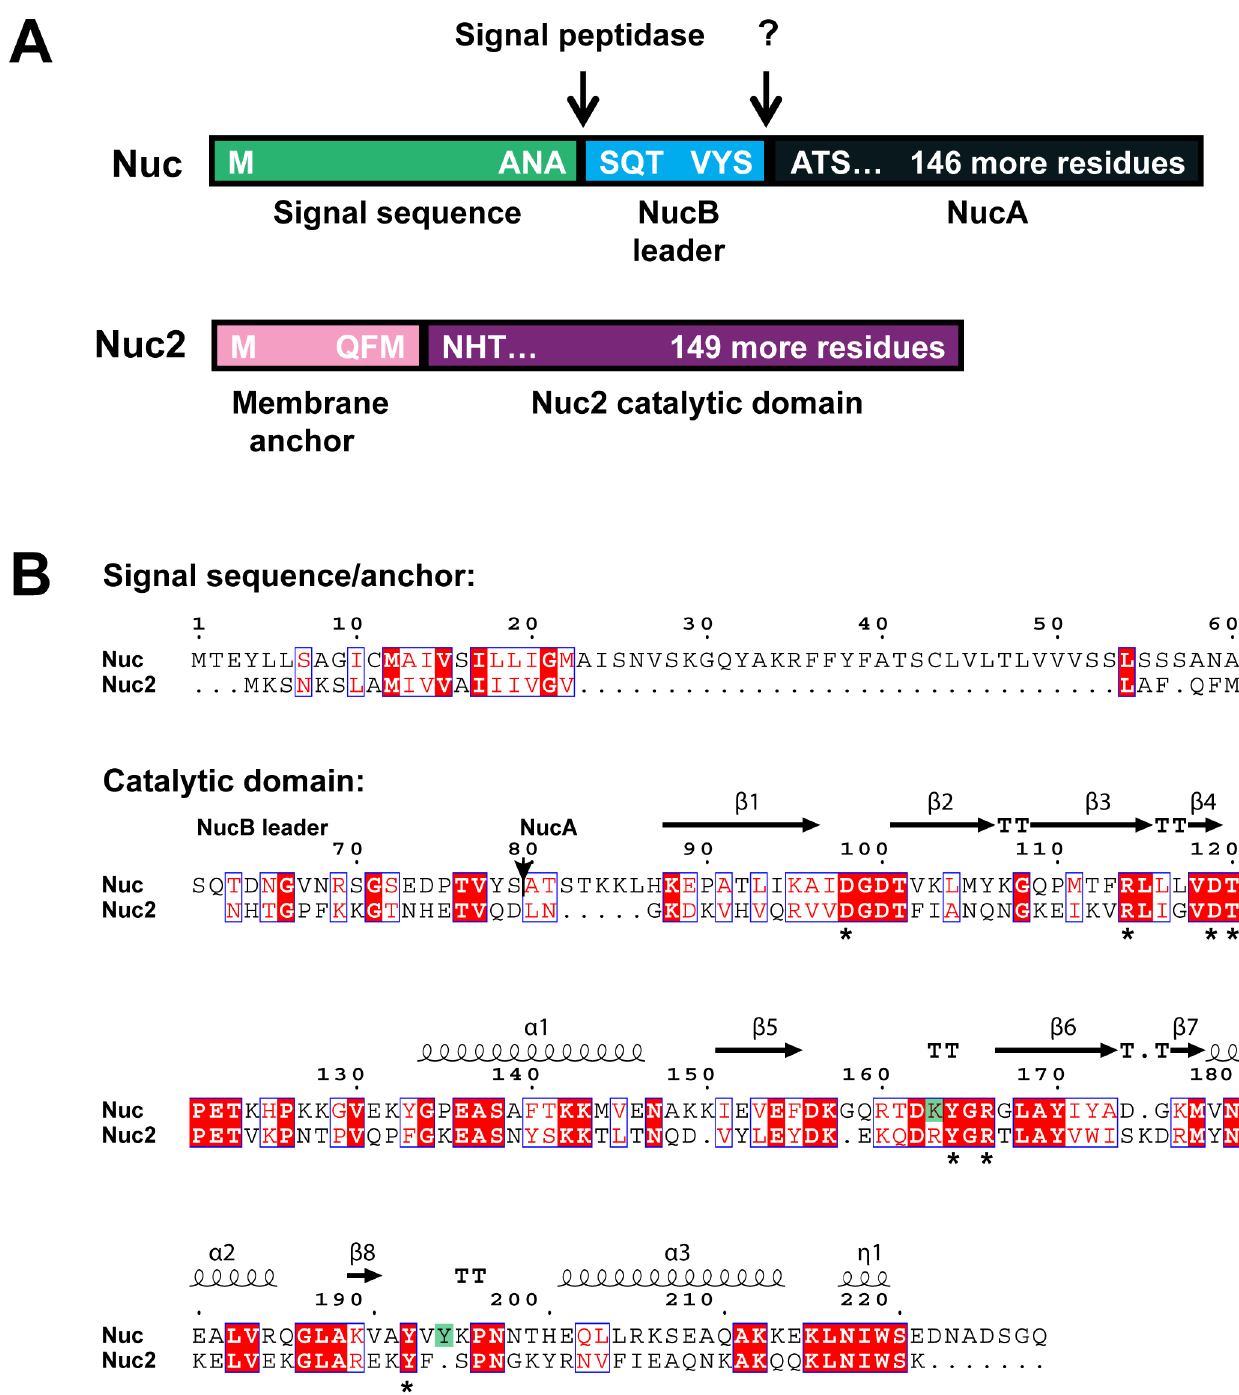
Figure 1. Sequence and structural comparison of the Nuc and Nuc2 proteins. A . Schematic of Nuc and Nuc2 protein domains structure, with processing sites shown. The Nuc protein is pictured in shades of teal and blue, showing the N-terminal signal sequence (light teal) cleaved by signal peptidase upon secretion, and the NucB leader (light blue) processed by an unknown protease to release the shorter active form NucA (dark teal). The Nuc2 protein is pictured in shades of purple and depicts the N-terminal membrane anchor (light purple) and the C-terminus containing the SNase active domain (purple). B . Amino acid alignment of Nuc (SA0776) and Nuc2 (SA1222) generated with Clustal Omega [52]. The Nuc signal sequence and Nuc2 membrane anchor regions are separated from the catalytic domain as indicated, and the location of NucA start is shown with an arrow at position 80. Structural information ( b -sheets and a -helices) was added with ESPript 3.0 [53] based on PDB entry 1EY0 for Nuc [54]. Identical residues are shaded red with white letters, and residues with similar properties are in red font surrounded by blue boxes. Asterisks underneath the alignment indicates residues conserved in Nuc and Nuc2, and the green shading indicates residues present only in Nuc.